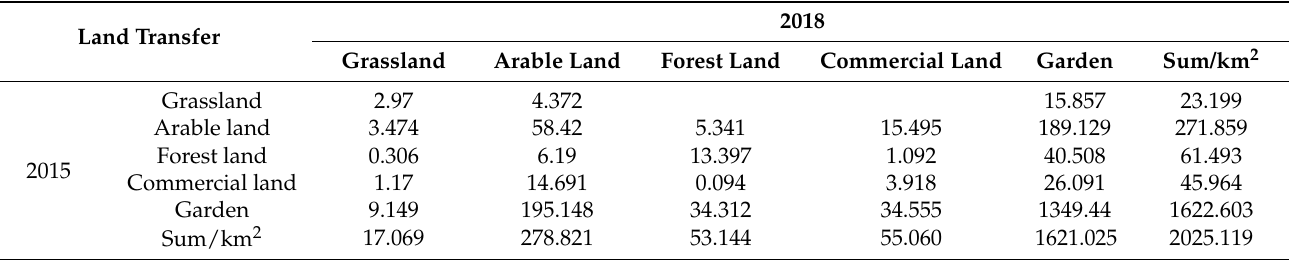
Table 6. Land use transfer matrix of 2015–2018.